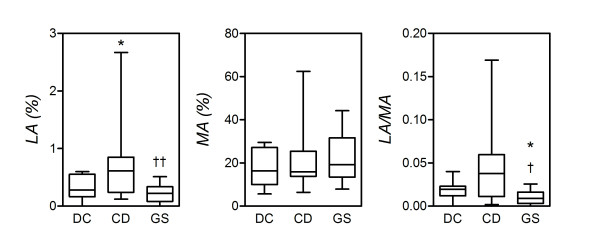
Reduced intestinal permeability in gluten-sensitive (GS) patients. Small intestinal permeability was probed by measuring the urinary cumulative 5-hour amount of lactulose (LA) (percentage of ingested), mannitol (MA) and the LA-to-MA ratio as described in (see Methods). Boxes represent the medians and interquartile ranges, and whiskers represent the range of independent determinations in 13 GS patients, 11 celiac disease (CD) patients, and 14 dyspeptic controls (DC) (see intestinal permeability section of the text, pages 8-9). *P < 0.05 relative to DC and †P < 0.05 relative to CD (Mann-Whitney U test).